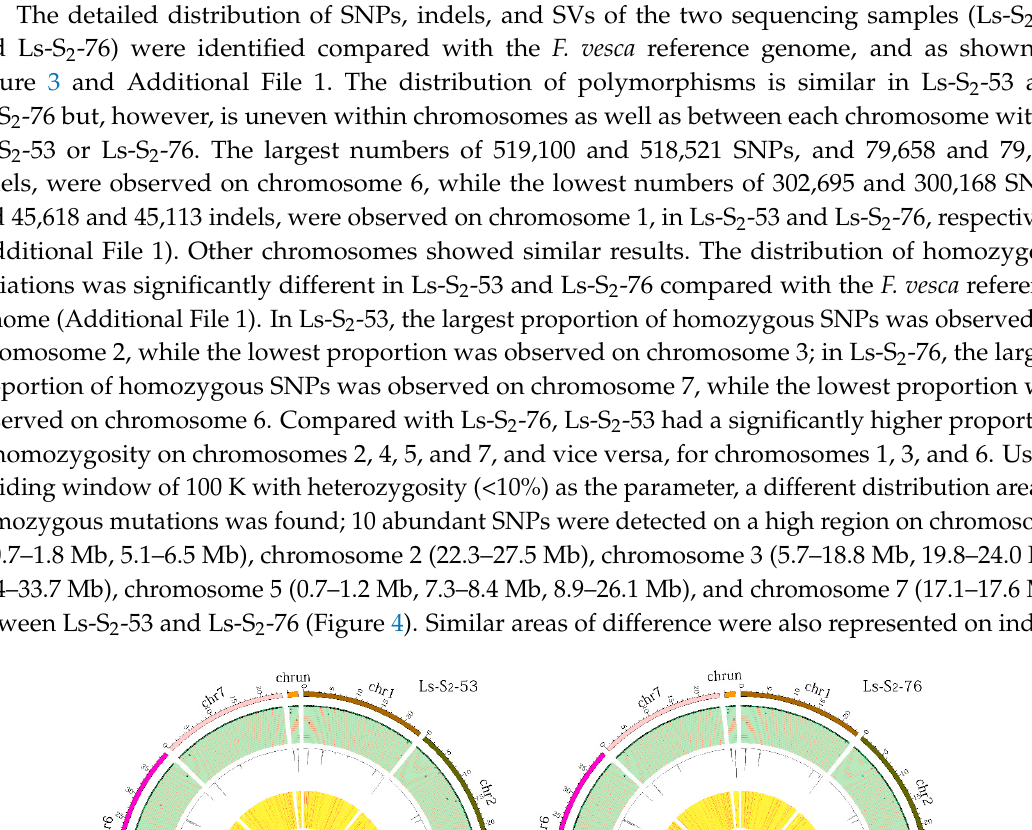
Figure 4. The specific distribution area of homozygous mutations (SNPs, indels) in Ls-S 2 -53 and Ls- S 2 -76 using a sliding window of 100 K with heterozygosity (<10%) as the parameter. The axis of abscissas and ordinates indicate the chromosomal location and number of variations, respectively.